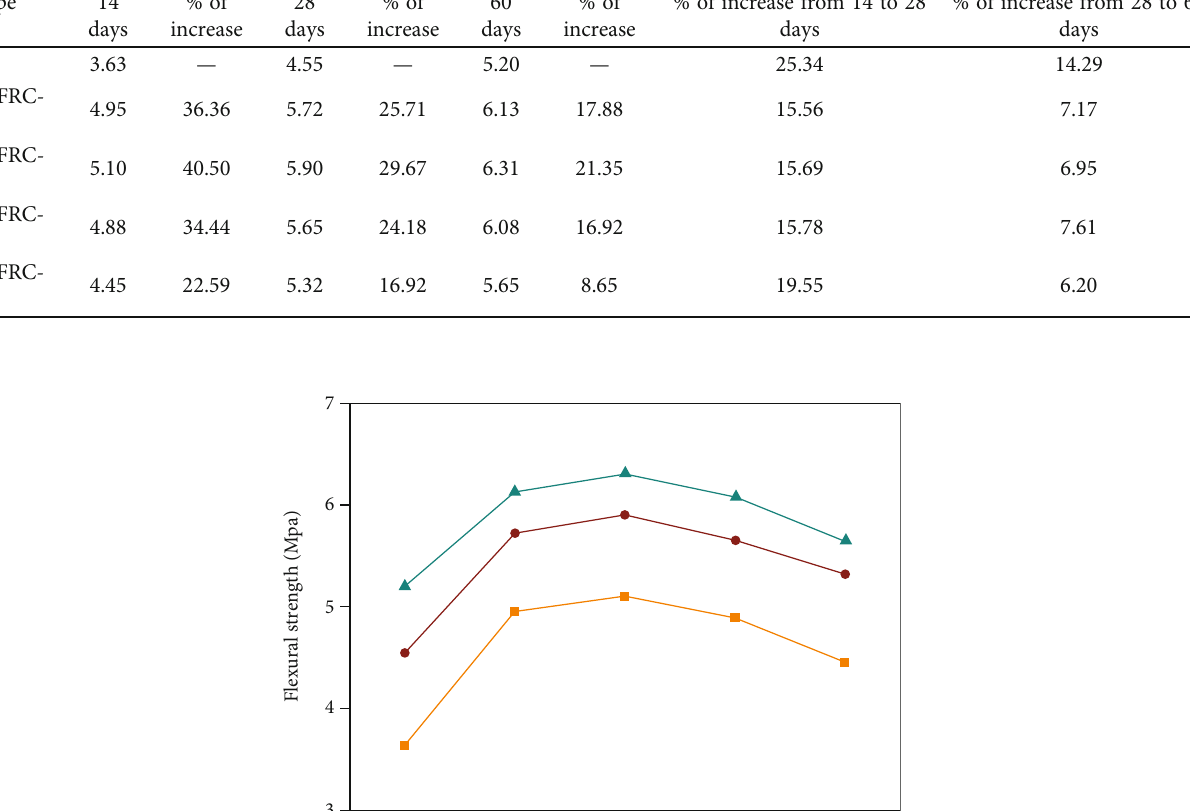
Table 9: The fl exural strength of PC and PPFRC at 14, 28, and 60 days of curing. Type